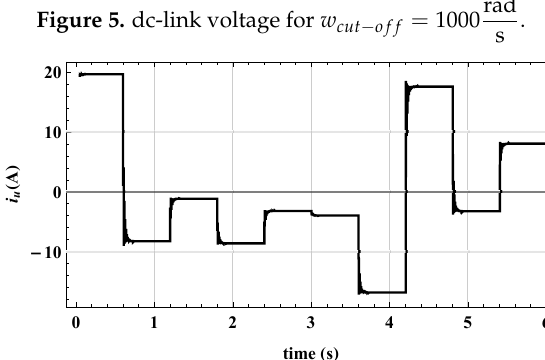
Figure 5. dc-link voltage for w cut − of f =